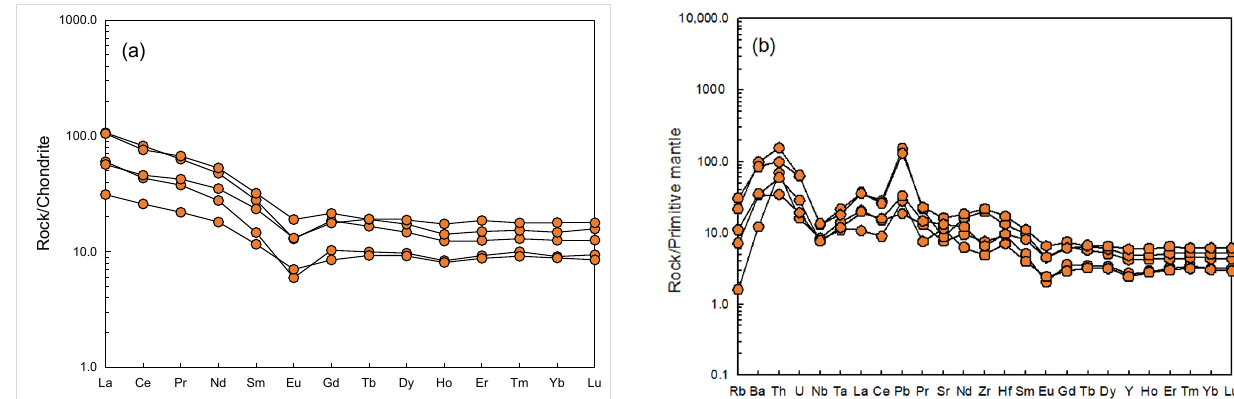
Figure 11. ( a ) Chondrite-normalized rare earth element (REE) patterns and ( b ) primitive mantle-normalized trace element patterns of the granitic pebble samples. Normalizing values are from [91]. Table 1. Chemical compositions of major elements (wt %) and trace elements ( × 10 − 6 ) of the Late Permian granitic pebble samples from the Jin (cid:48) gui